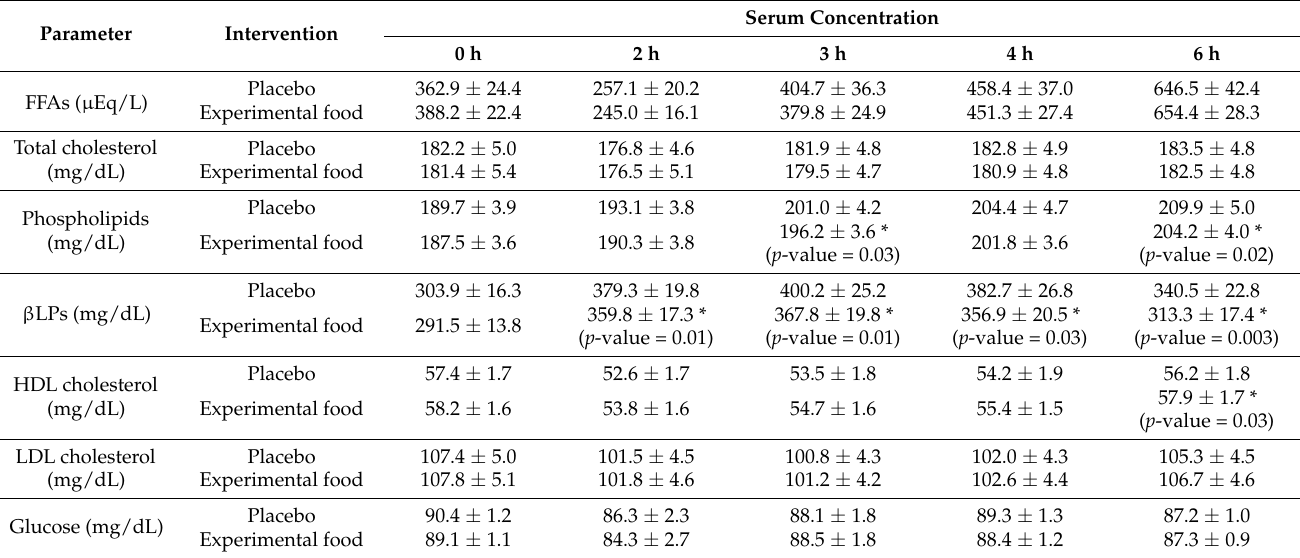
Table 4. Postprandial serum concentrations of other lipidemic and glycemic